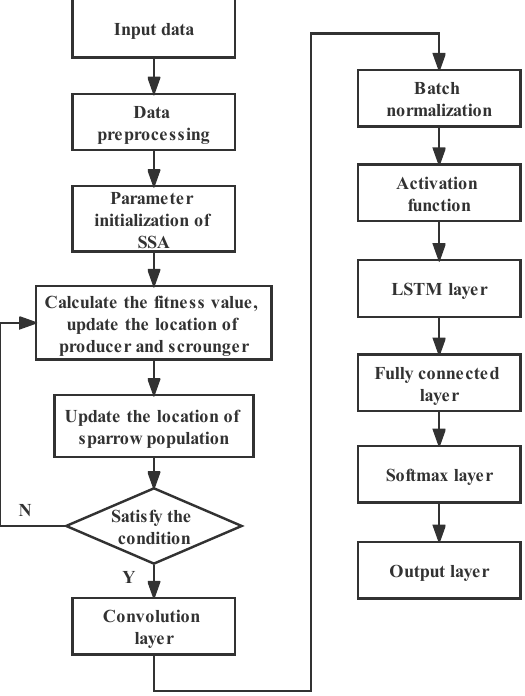
Figure 5. Flow chart of the SSA-CNN-LSTM model.